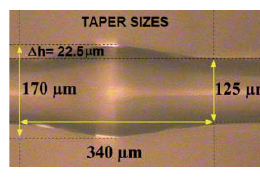
Figure 2. Microscope photo of the up taper constructed in [54].